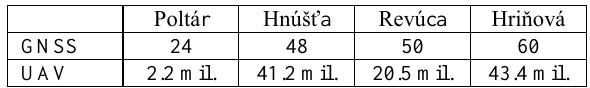
Table 2. Number of used points for volume calculation